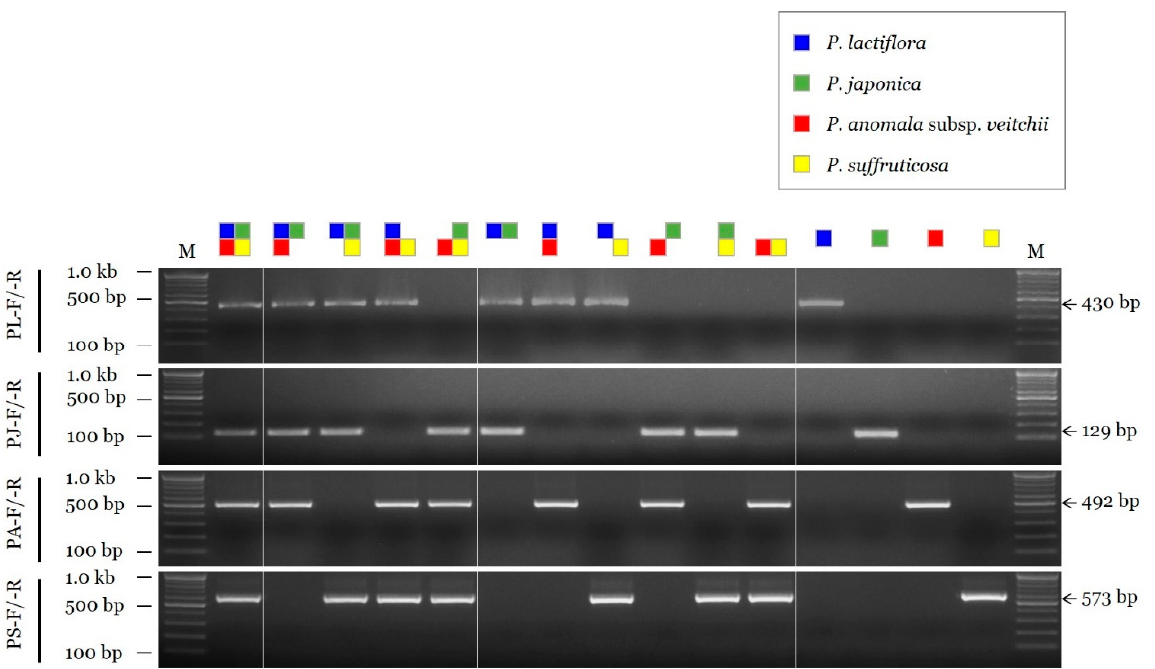
Figure 3. Assessment of the discriminability of SCAR primers using mixed DNA samples. The composition of each DNA sample is shown on the top using different colored squares (blue, P. lactiflora ; green, P. japonica ; red, P. anomala subsp. veitchii ; yellow, P. suffruticosa ). SCAR primer combinations (PL-F/-R, PJ-F/-R, PA-F/-R, and PS-F/-R) and 100 bp, 500 bp, and 1.0 kb bands of the 100 bp DNA marker (M) are indicated on the left. Arrows and numbers on the right indicate the amplicon size.